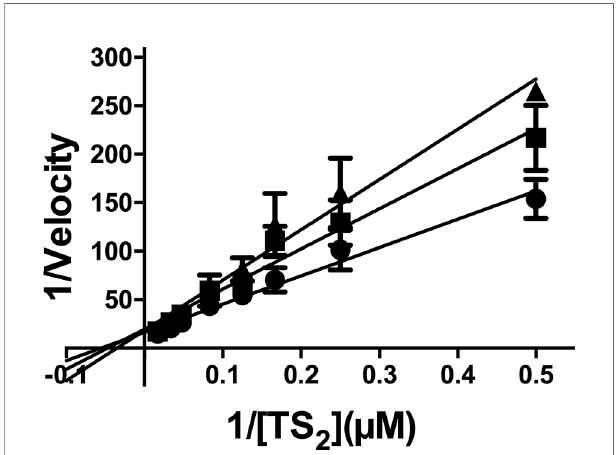
FIGURE 6 | Kinetic analysis of TR activity in the presence of EGCG. The enzyme concentration was maintained as a constant, while the substrate [T(S) 2 ] varied as described in the abscissa, and EGCG varied as follows: no addition (closed circles); 100 µM EGCG (closed squares); 200 µM EGCG (closed triangles). The values are presented as the mean ± standard error of three different experiments run in